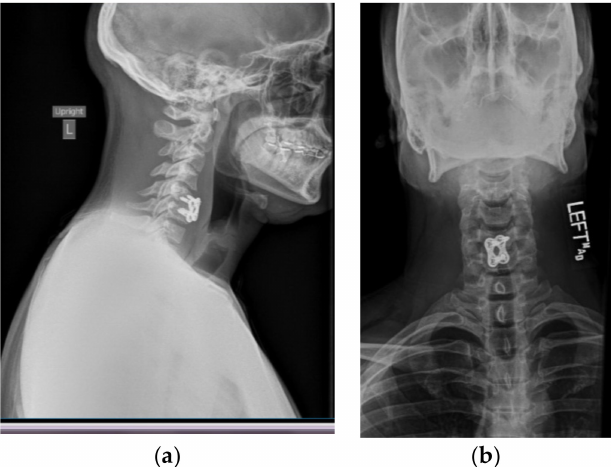
Figure 3. Postoperative X-ray showing postsurgical changes related to anterior fusion at C5–C6, with interval decrease in prevertebral soft tissue swelling. C1–C7 are visualized on the lateral view (Figure 3a) for evaluation of alignment. There is straightening of the normal cervical lordosis. Alignment is otherwise grossly unremarkable when allowing for patient rotation. Anterior instrumentation